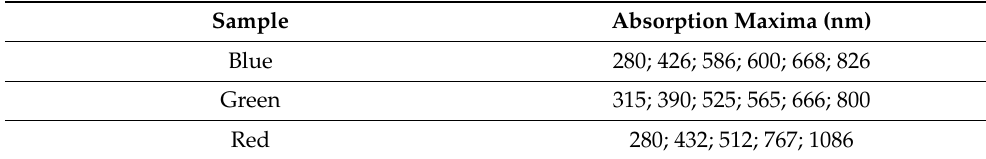
Table 4. UV–Vis maxima for blue, green and